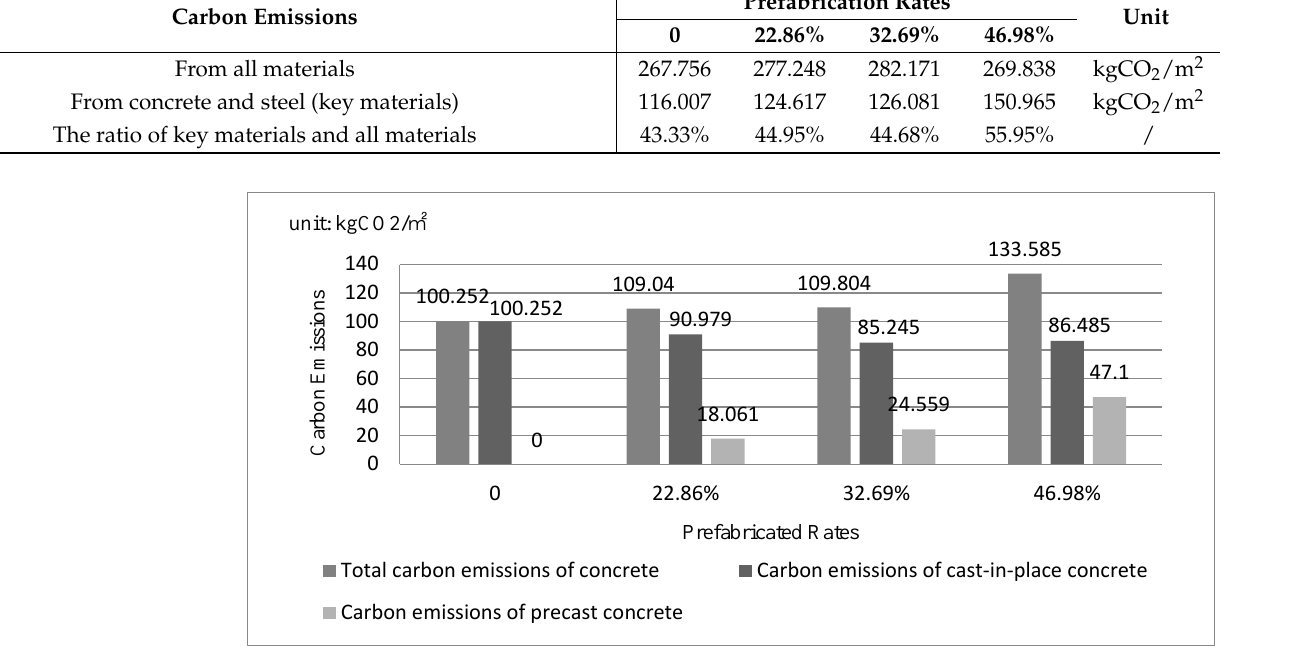
Figure 6. Carbon Emissions from Concrete under Different Prefabrication